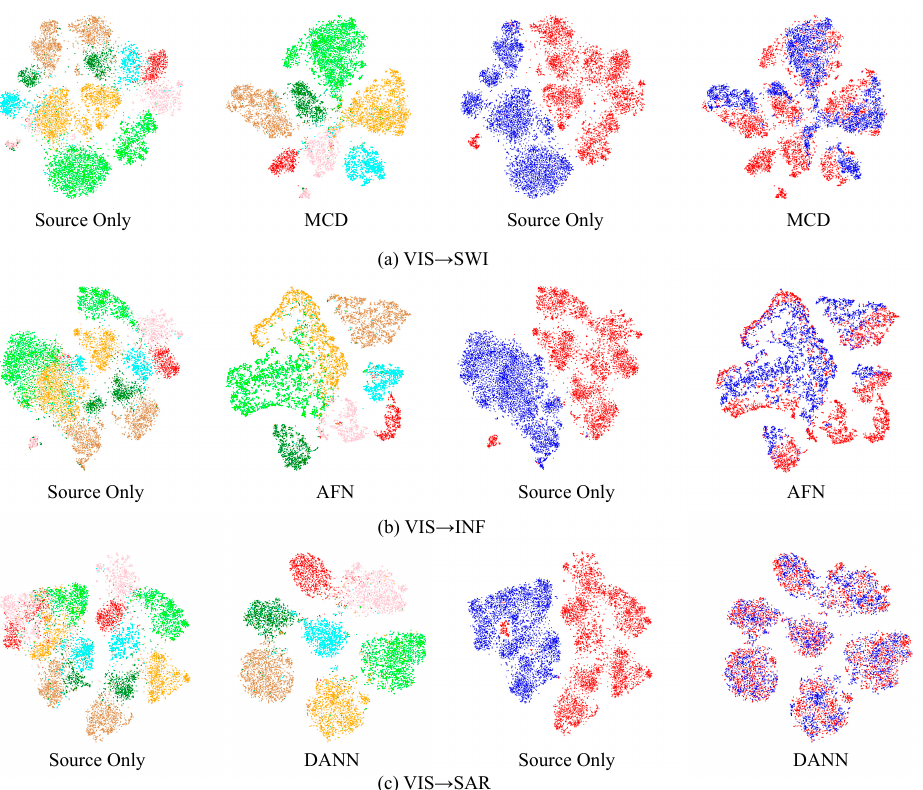
Figure 5. T-SNE visualizations of the features from distinct DA methods on the ( a ) VIS → SWI task, ( b ) VIS → INF task and ( c ) VIS → SAR task. First and second columns are generated from category information, and each color point indicates a category. Third and fourth columns are generated from domain information; blue points indicate source domain data, and red points indicate target domain data.